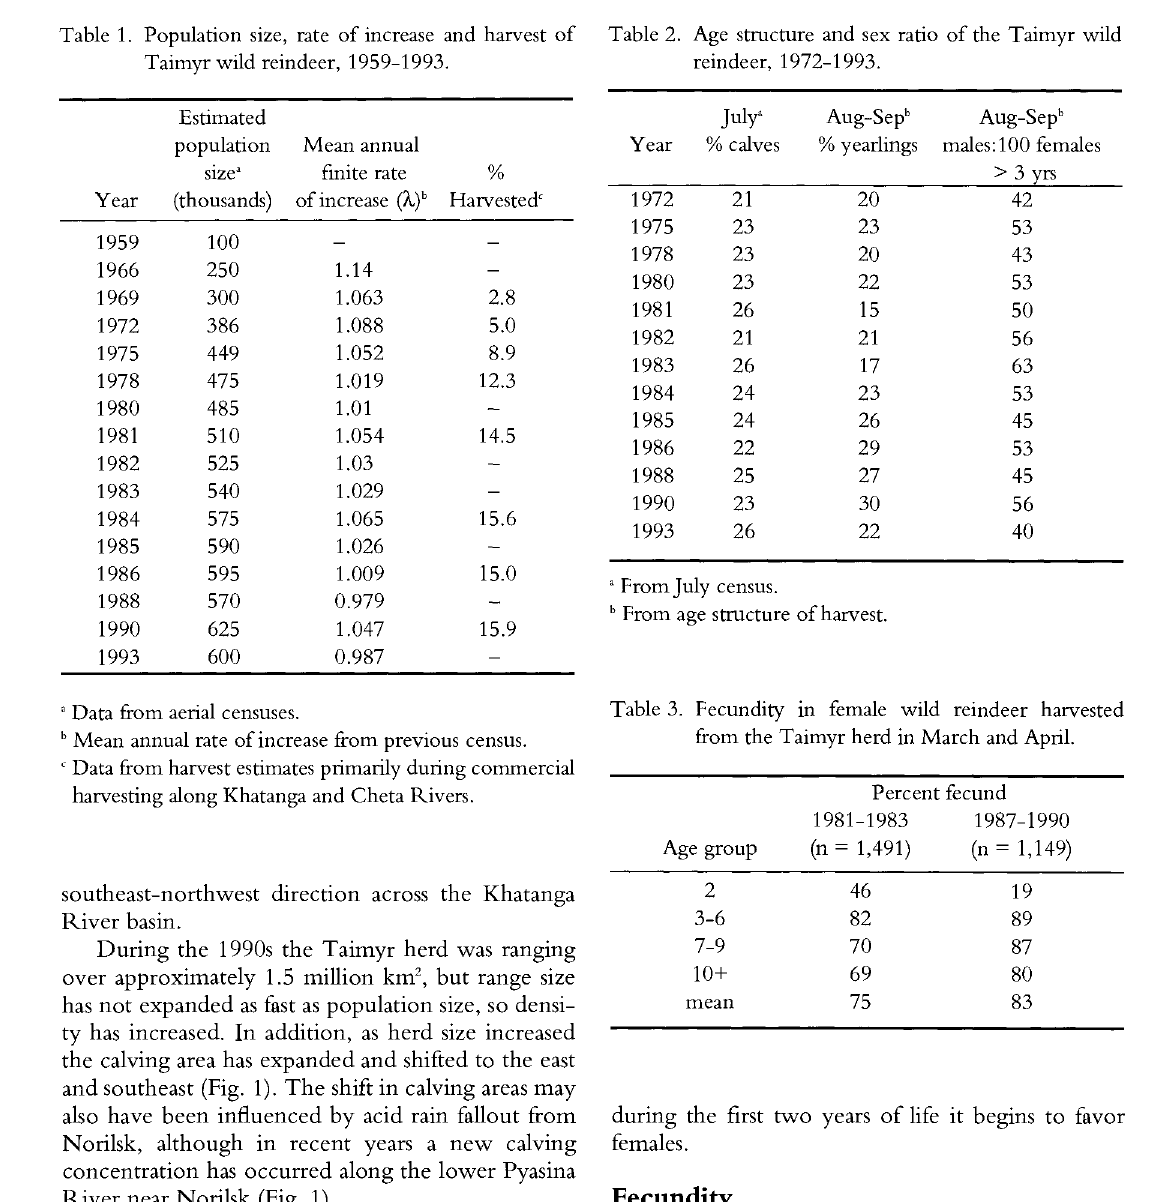
Table 2. Age structure and sex ratio of the Taimyr wild reindeer, 1972-1993.